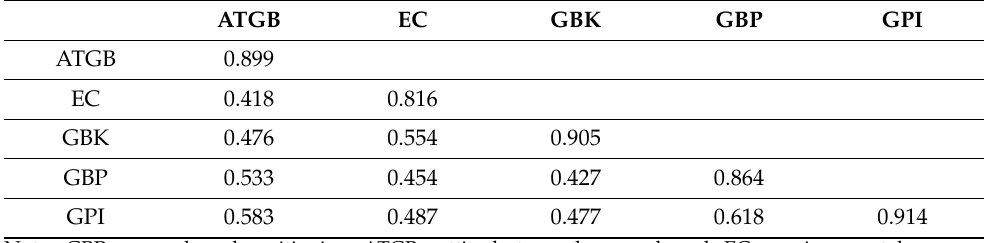
Table 3. Discriminant validity Fornell and FornellLarcker [126].